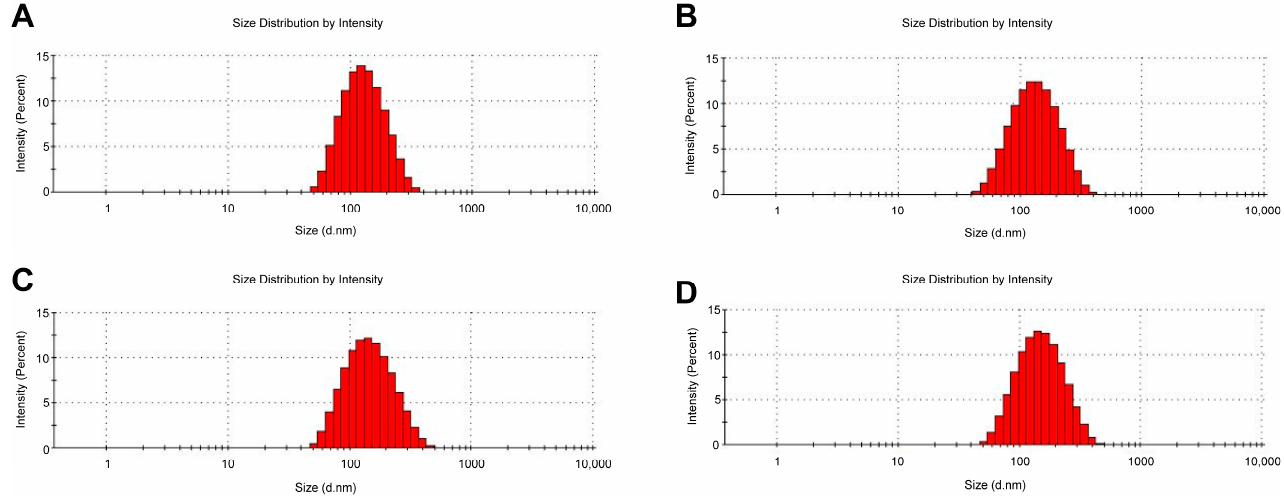
Figure 1. Particle size distribution of GEM liposomes measured by DLS, including ( A ) L-GEM, ( B ) ES-L-GEM, ( C ) SSL-GEM, and ( D ) ES-SSL-GEM.